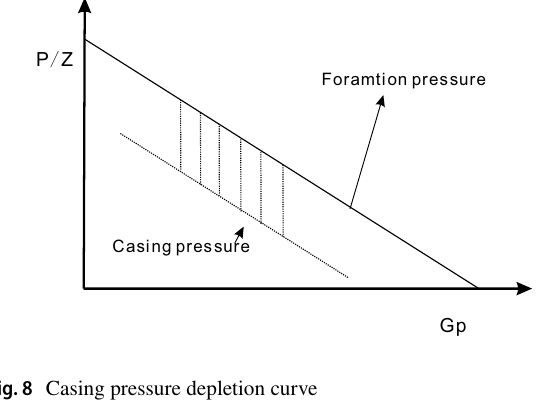
Fig. 8 Casing pressure depletion curve